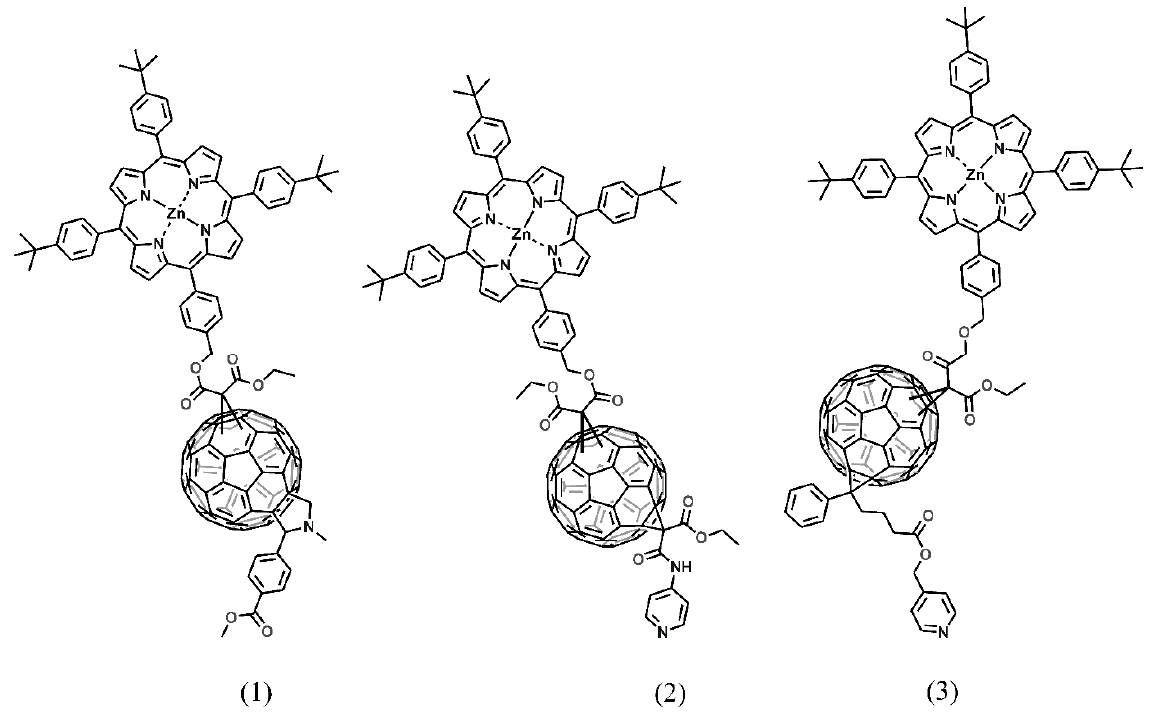
Figure 1. Structures of the fullerene derivatives: 1 , 2 and 3 .